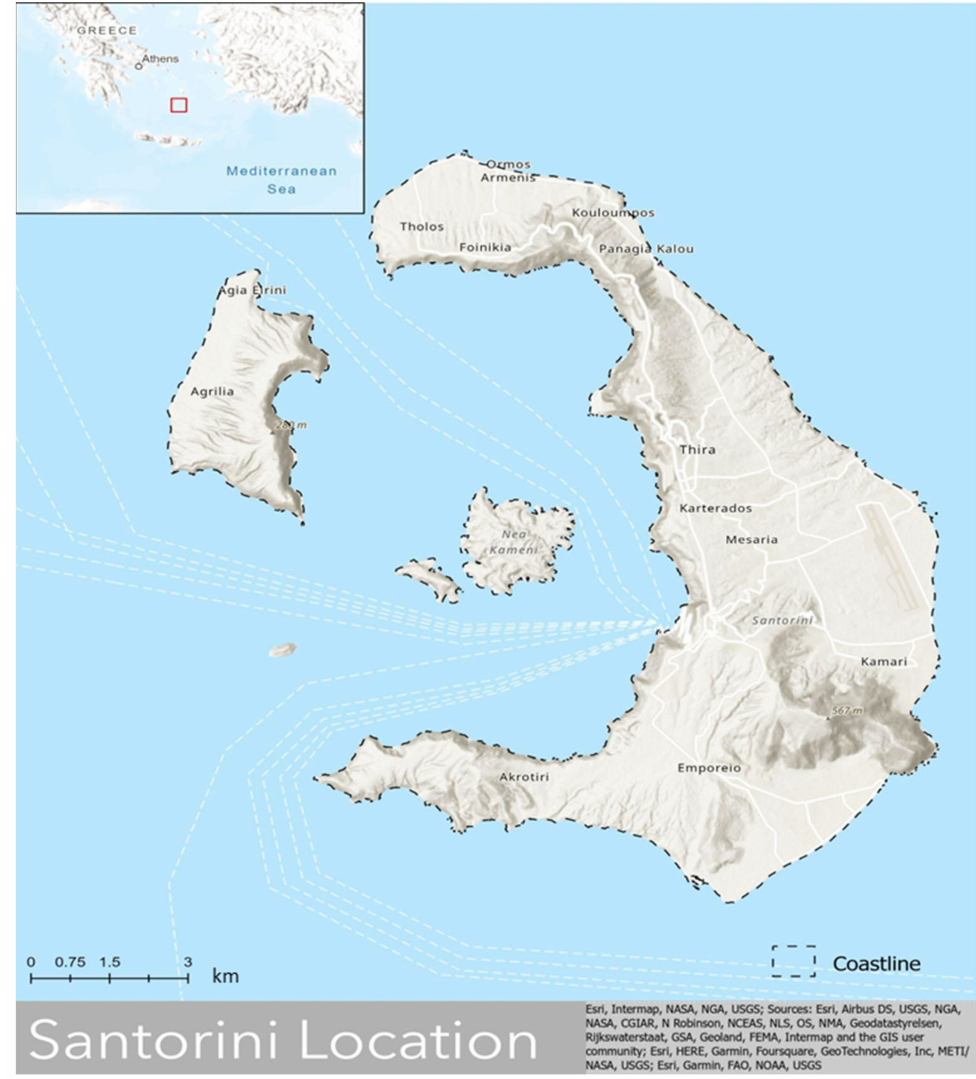
Figure 3. Topographic map of Santorini Island complex. Thira is the largest island on the right part of the image. Inset map: Location of Santorini Island complex regarding Hellenic region (ESRI